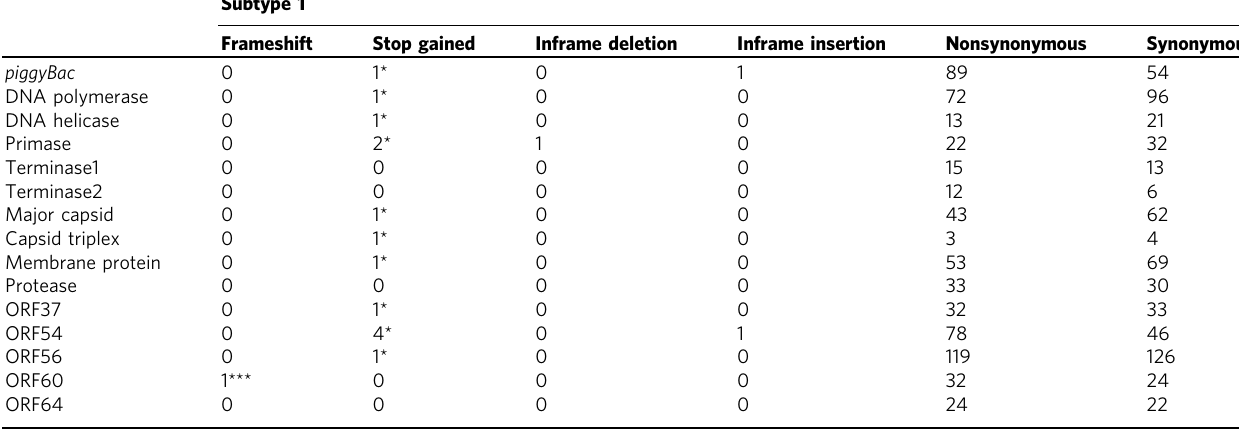
Table 1 Number of variants at the core herpesvirus genes among all subtype 1 Teratorn copies in the medaka genome